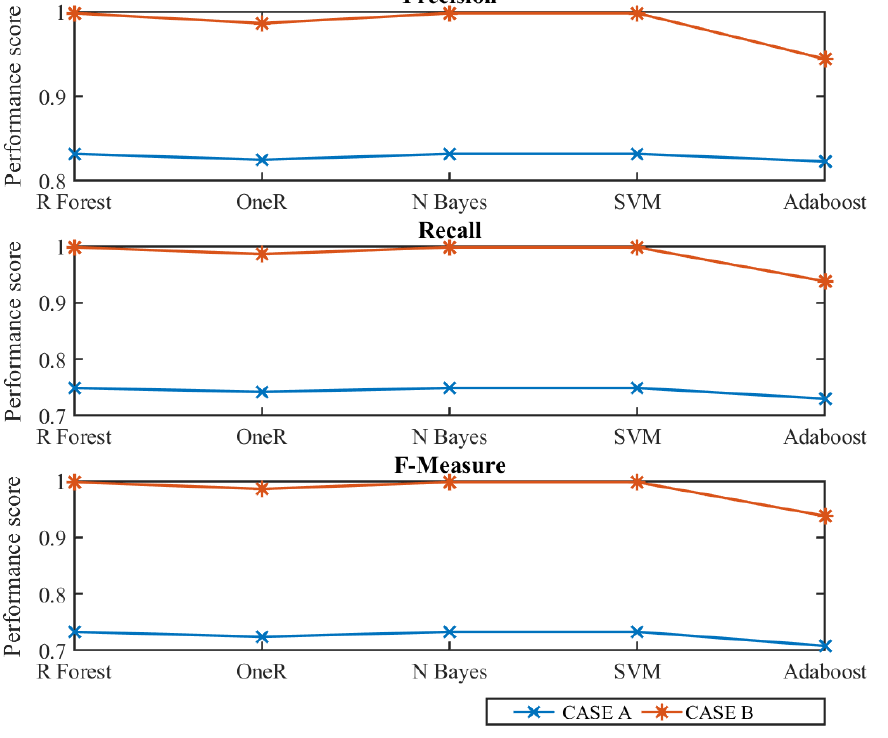
Figure 5. Precision, Recall, and F-measure of different MLAs for CASES A and